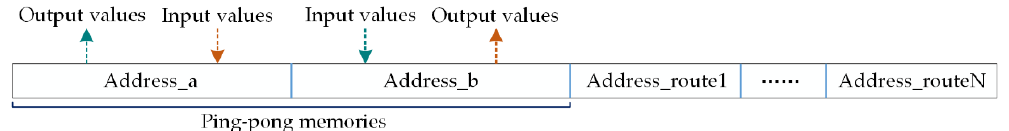
Figure 12. The diagram of the storage strategy in the processing system (PS)-DDR.